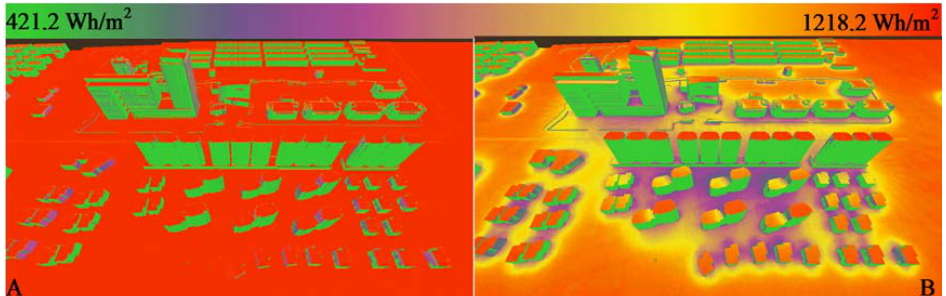
Figure 14. Spatial distribution of diffuse irradiation before ( A ) and after ( B ) SVF scaling.